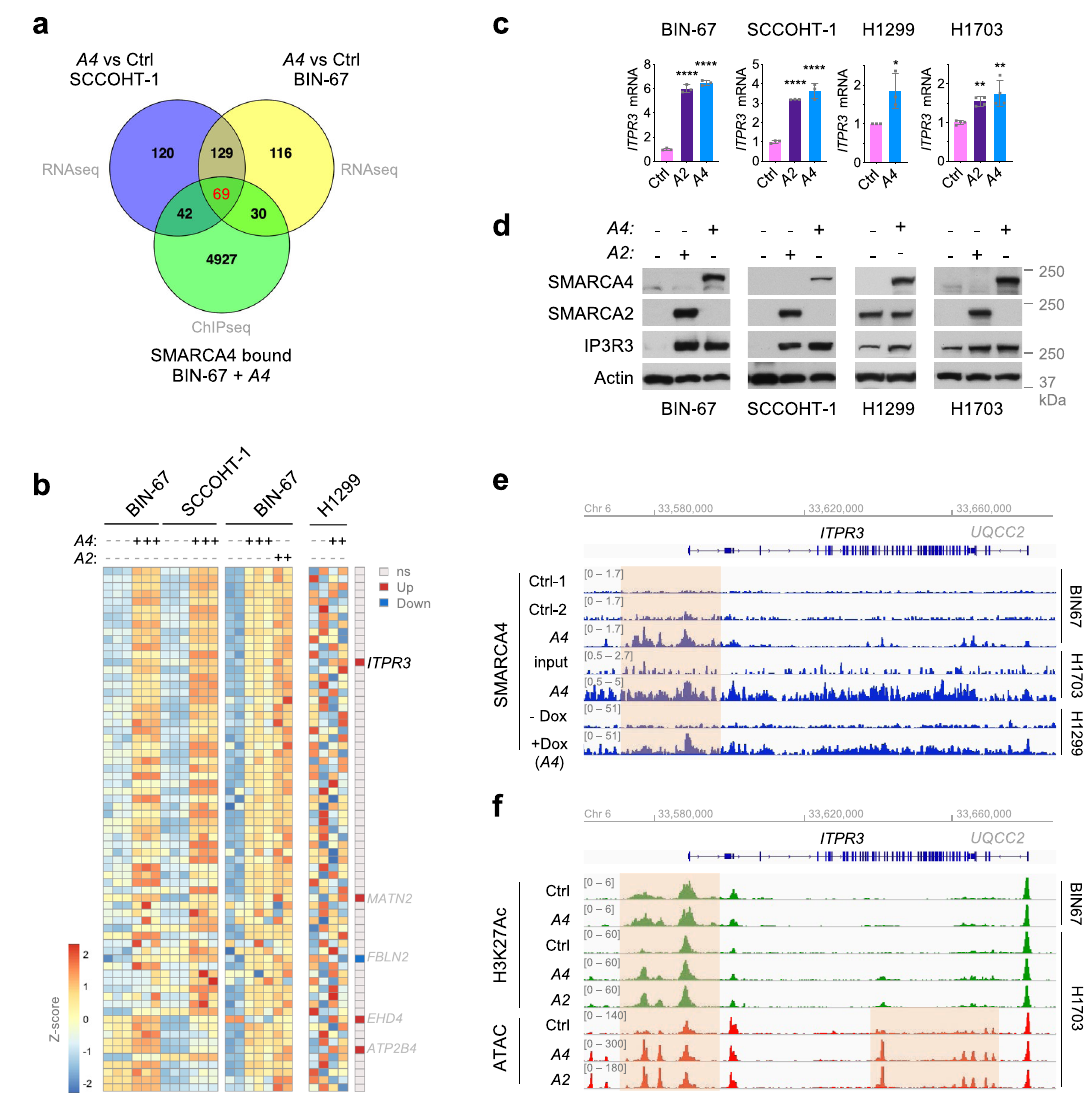
Fig. 3 SMARCA4/2 regulate ITPR3 transcription through remodeling chromatin accessibility at its gene locus. a Venn diagram of Ca 2 + -related genes from Fig. 2a, b that are enriched in SCCOHT-1 and BIN-67 cells with SMARCA4 restoration. b Heatmap of Ca 2 + -related genes bound by SMARCA4 ( n = 69) in indicated SCCOHT (SCCOHT-1 and BIN-67) and NSCLC (H1299) cell lines with SMARCA4/2 restoration. Left: normalized reads from RNA- seq data of BIN-67 and SCCOHT-1 cells with SMARCA4 restoration 49 . Middle: normalized reads from RNA-seq data of BIN-67 cells with SMARCA4/2 restoration 60 . Right: normalized signal from microarray data of H1299 cells with SMARCA4 restoration 61 . Row scaling was used to generate the heatmap. The last column represents changes of genes in H1299 cells ± SMARCA4 restoration: ns not signi fi cant, up upregulated, down downregulated. c RT-qPCR measurements of ITPR3 mRNA expression in indicated SCCOHT and NSCLC cell lines with SMARCA4/2 restoration. GAPDH was used for normalization. Mean± SD, n = 3 (BIN-67, SCCOHT-1, H1299) or 4 (H1703) independent experiments, one-way ANOVA followed by Dunnett ’ s test for multiple comparisons to the control group (BIN-67, SCCOHT-1, H1703) or two-tailed t -test (H1299), p values ( p ): BIN-67, all <0.0001; SCCOHT-1, A2 — 0.0004, A4 — 0.0001; H1299 — 0.0318; H1703, A2 — 0.0097, A4 — 0.0013. d Immunoblots of indicated proteins in indicated SCCOHT and NSCLC cell lines ± SMARCA4/2 restoration. e SMARCA4 occupancy in vicinity of the ITPR3 locus assessed by chromatin immunoprecipitation sequencing (ChIP-seq) in indicated SCCOHT and lung cancer cell lines ± SMARCA4 restoration. SMARCA4 in H1299 cells was induced by doxycycline (Dox) 61 . Track height is normalized to relative number of mapped reads. f Chromatin structure changes in vicinity of the ITPR3 locus assessed by H3K27Ac ChIP-seq and assay for transposase-accessible chromatin sequencing (ATAC-seq) in indicated SCCOHT and lung cancer cell lines ± SMARCA4/2 restoration. Track height is normalized to relative number of mapped reads. a – f Ctrl control, A4 SMARCA4 , A2 SMARCA2 . * p < 0.05, ** p < 0.01, **** p <